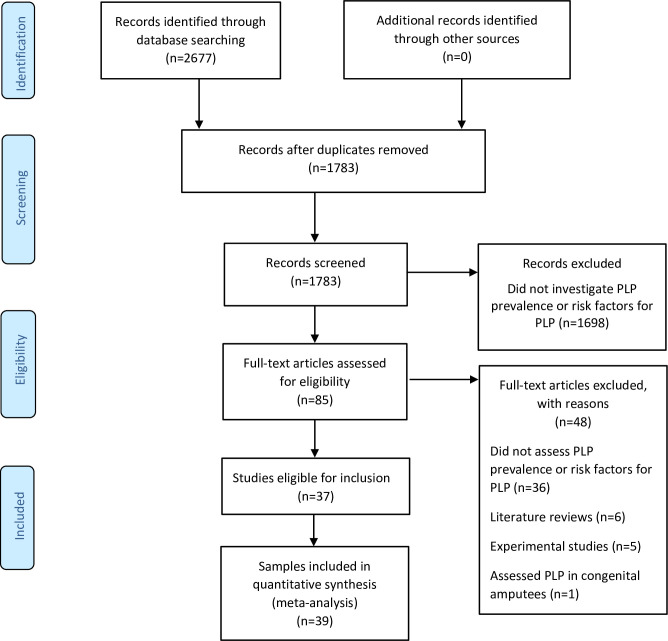
The PRISMA flow diagram illustrating the screening process.